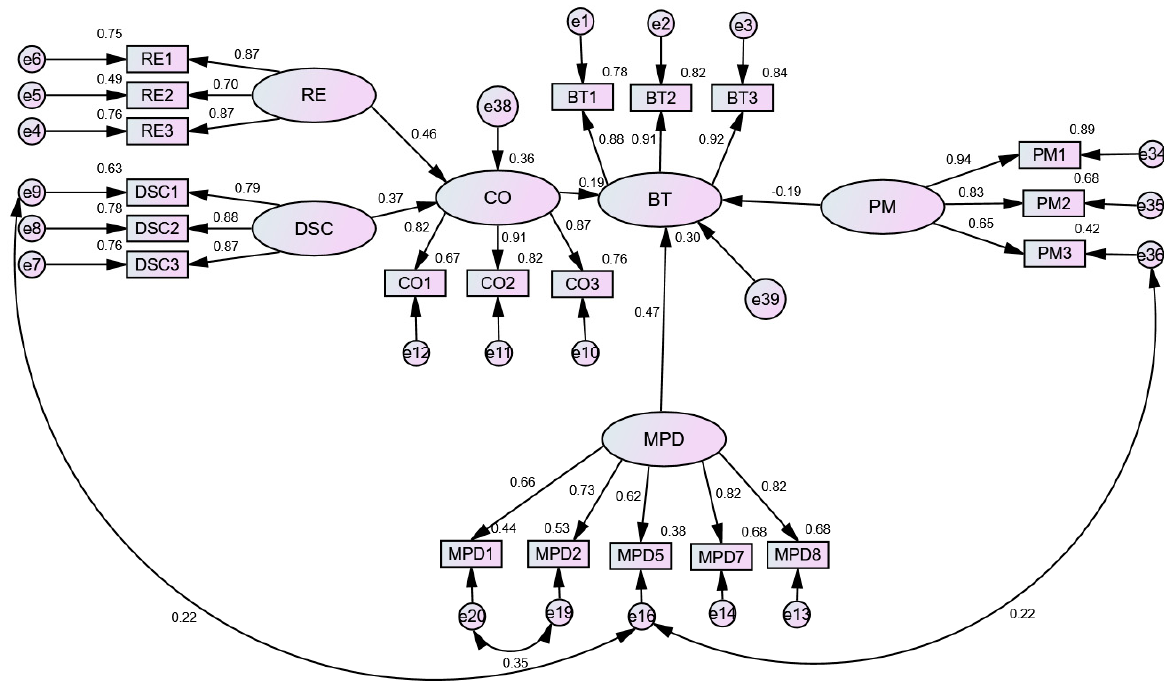
Figure 1. Analysis results of the causes of mobile phone use while riding (Model 1). Hypothesis 12 (H12). The road environment (RE) has a significant positive impact on the con- trollable operation (CO) ( β = 0.46, p < 0.001).